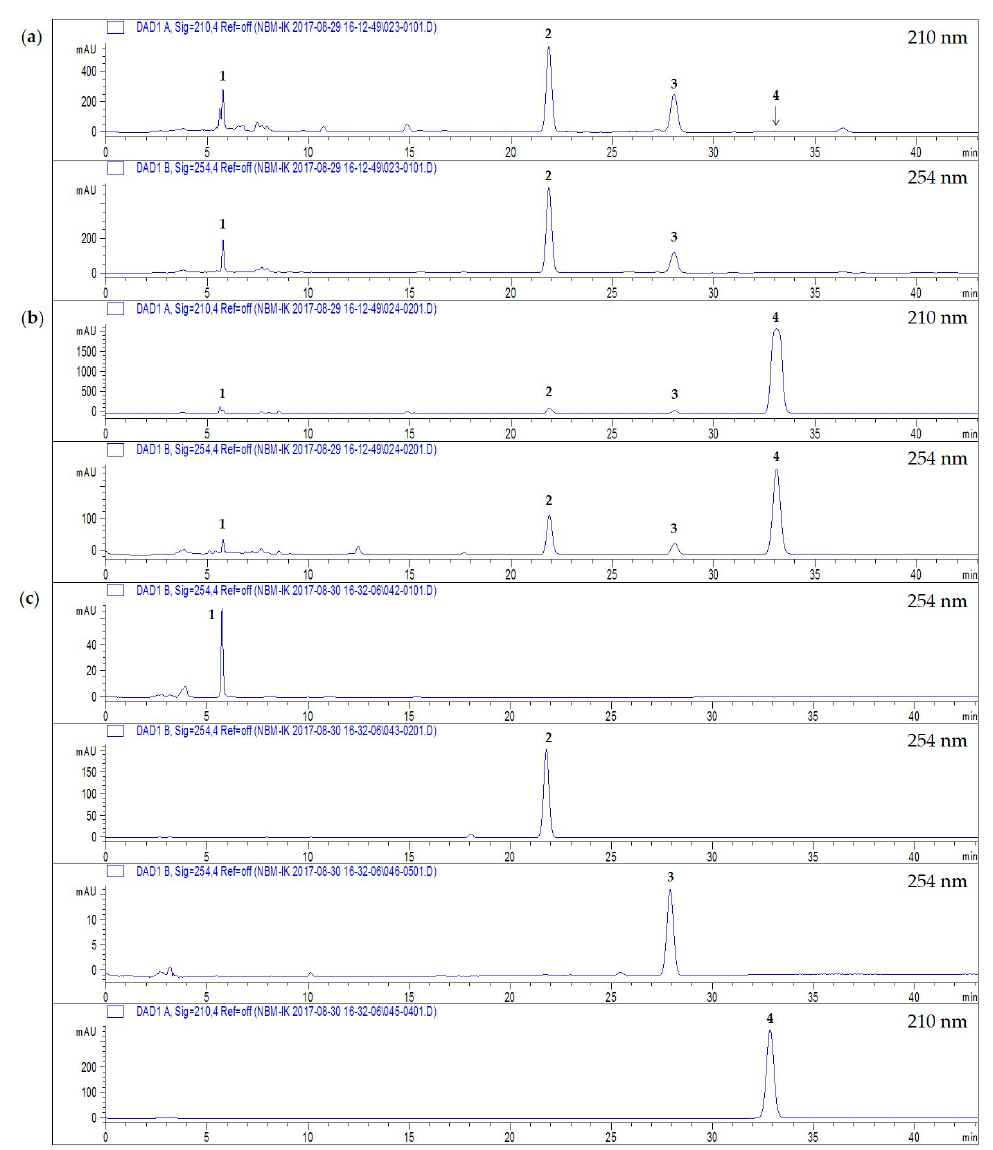
Figure 5. HPLC chromatograms of ( a ) the SC-CO 2 extract of PFCA at 210 and 254 nm; ( b ) the SC-CO 2 extract of PFC at 210 and 254 nm; ( c ) the four standards: 9-hydroxy-isoegomaketone ( 1 ), isoegomaketone ( 2 ), and perilla ketone ( 3 ) at 254 nm and myristicin ( 4 ) at 210 nm.